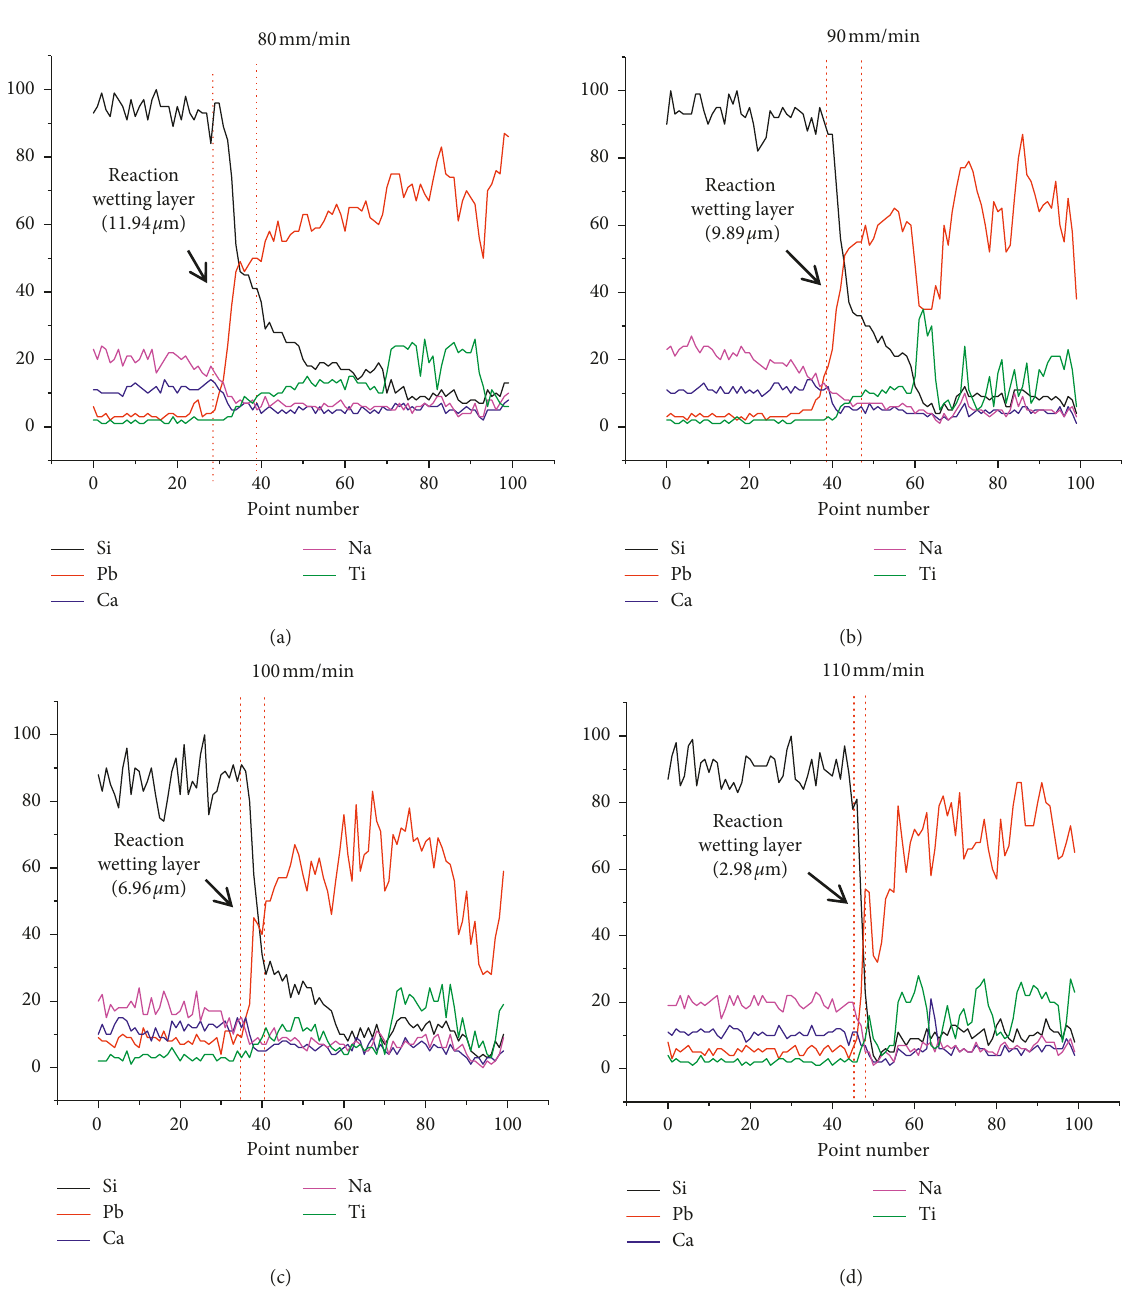
Figure 4: Results of the line scan of the joint interface at different welding speeds. Table 2: Hardness, tensile strength, and shear strength values of the sealing layer at different welding speeds. Welding speed